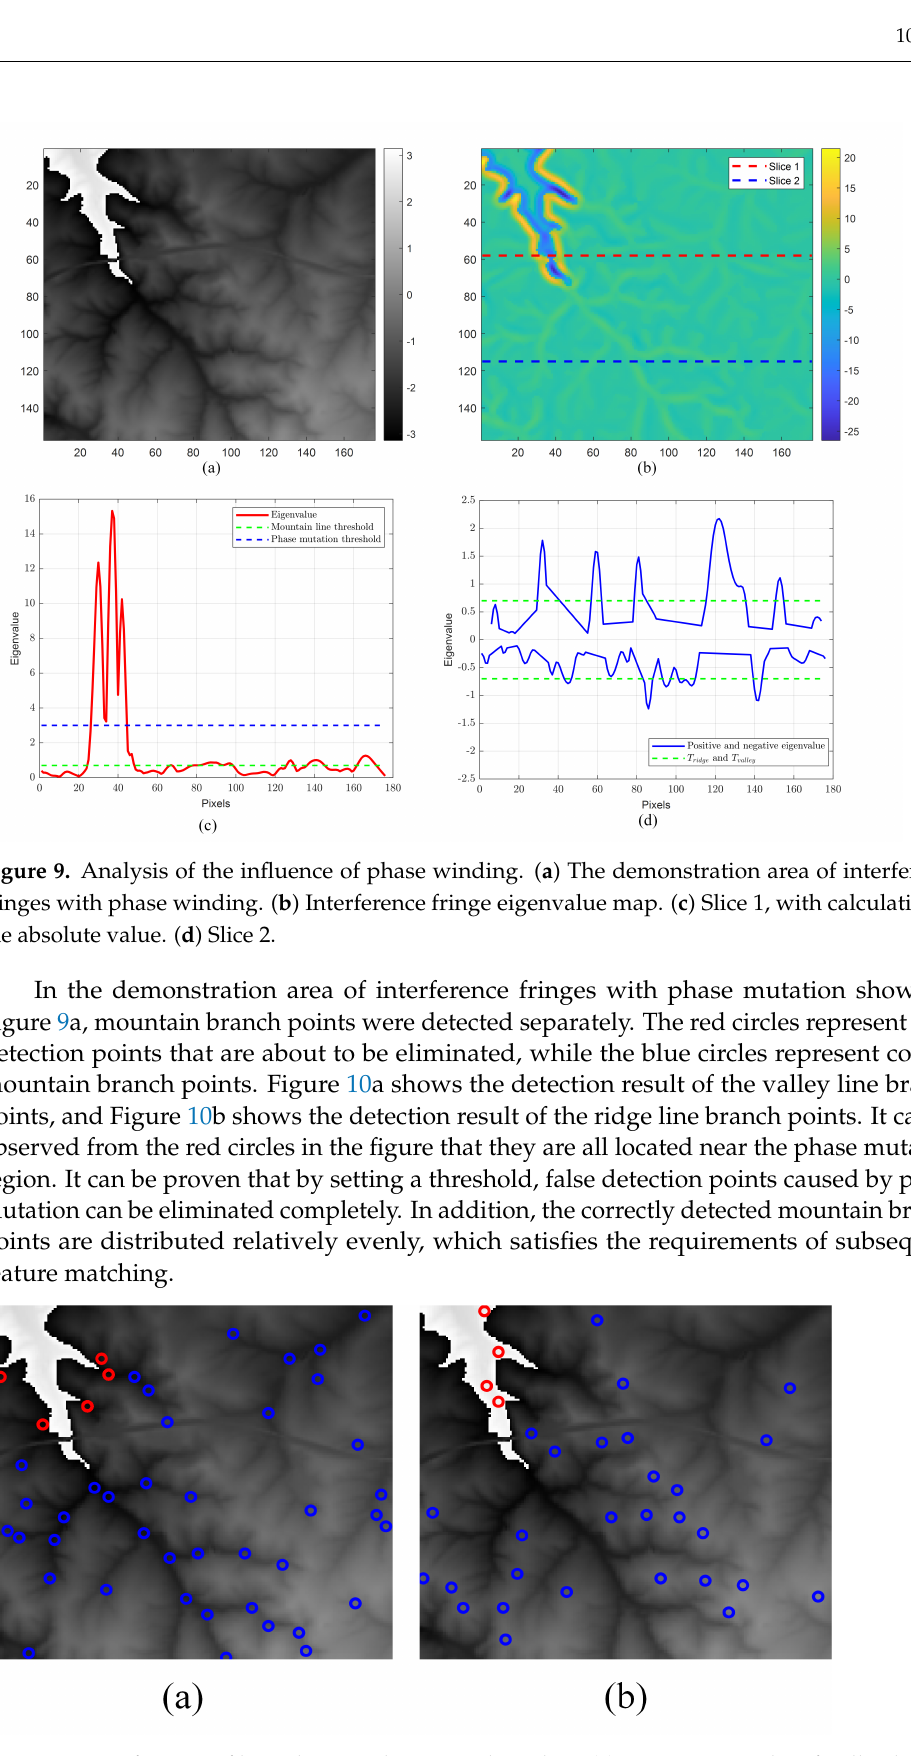
Figure 10. Verification of branch point detection algorithm. ( a ) Detection results of valley branch points of interference fringe with phase mutation. ( b ) Detection results of ridge branch points of interference fringe with phase